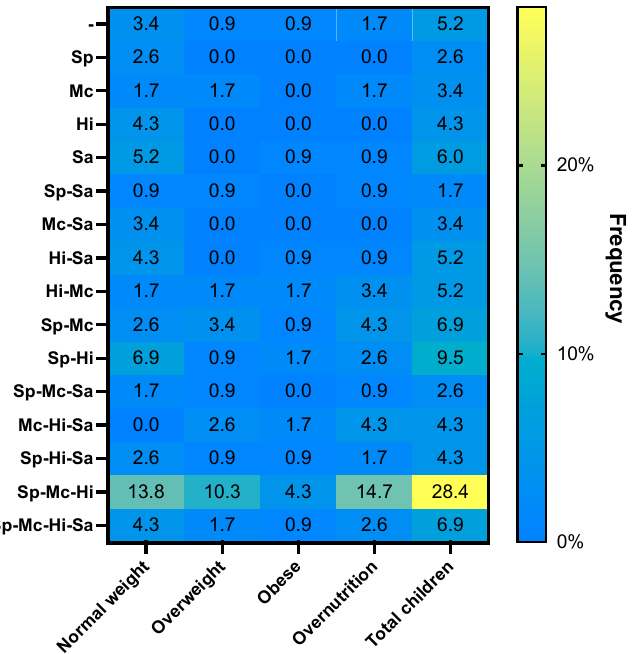
Figure 2. A two-dimensional heatmap showing the frequency of four nasopharyngeal pathogenic bacteria, as a single or multiple detection according to the nutritional status of children. -: no bacteria detected; Sp, S. pneumoniae ; Mc, M. catarrhalis ; Sa, S. aureus ; Hi, H. influenzae. We then analyzed the presence and bacterial burden for each bacterium according to the children’s nutritional status. Only detection of M. catarrhalis was more frequent ( p = 0.001) as well as M. catarrhalis loads ( p = 0.022) in children with overnutrition (which in- cluded those with overweight or obese) compared with those with normal weight (Figures 3A, B).